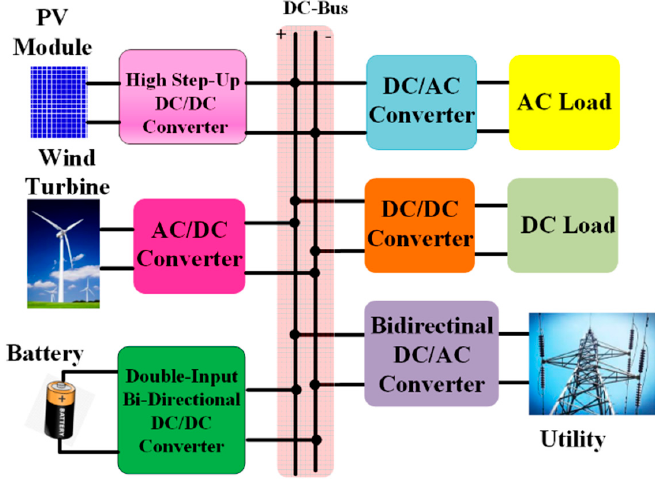
Figure 1. General layout of a hybrid microgrid system.